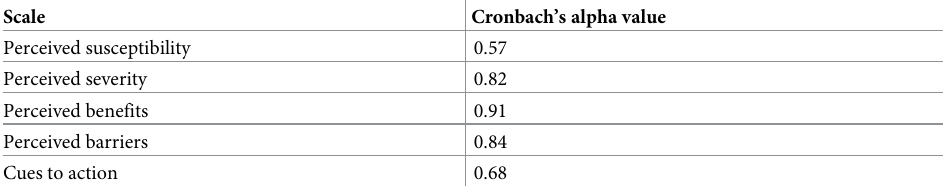
Table 1. Reliability score of attitudinal aspects of questions towards HIV/AIDS and STIs